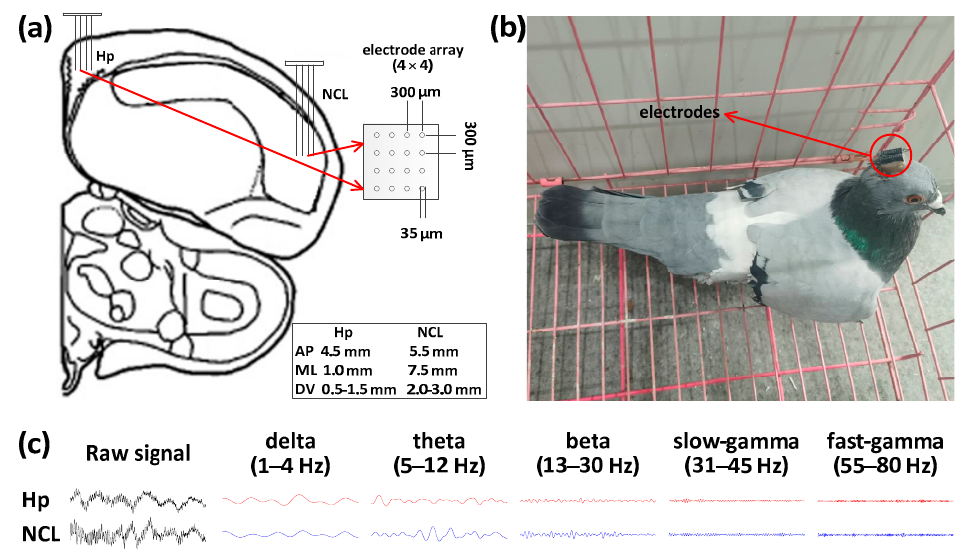
Figure 2. Implantation sites, microelectrode array, pigeon with implanted arrays, and LFP traces. ( a ) Diagram of implanting location Hp and NCL with the microelectrode array. AP: anteroposterior, ML: mediolateral, DV: dorsoventral. ( b ) Photograph of a pigeon (pigeon ID: P097) implanted with microelectrode arrays. ( c ) Examples of simultaneous LFP traces recorded from the Hp and NCL, filtered at delta, theta, beta, slow-gamma, and fast-gamma frequency bands (pigeon ID: P097).